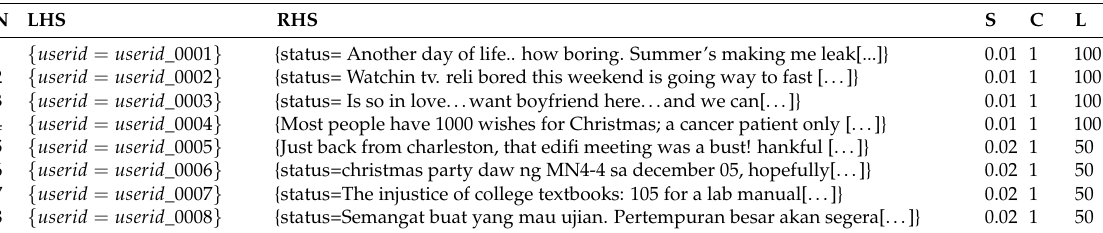
Table 5. Top 8 rules extracted from FB posts.